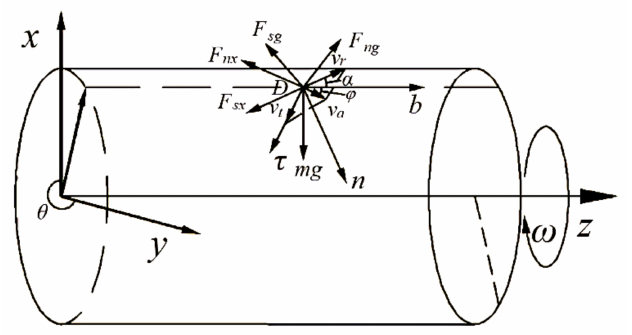
Figure 8. Schematic diagram of stress on the side of the top cover.